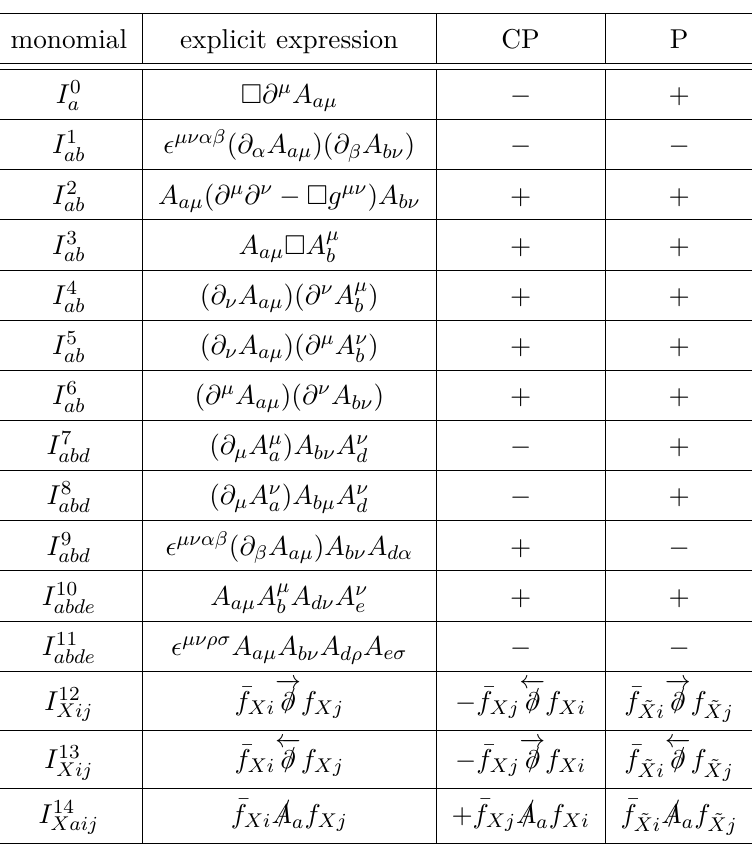
Table 1 . Basis of local, dimension-four operators depending on gauge bosons, fermions and their derivatives entering the decomposition of ∆ a | shown are the transformation properties under CP and P. For the fermion bilinears I 12 I 14 , i, j being flavour indices, we explicitly display their CP- and P-transformed versions, with Xaij ˜ L ( ˜ R ) = R ( L )